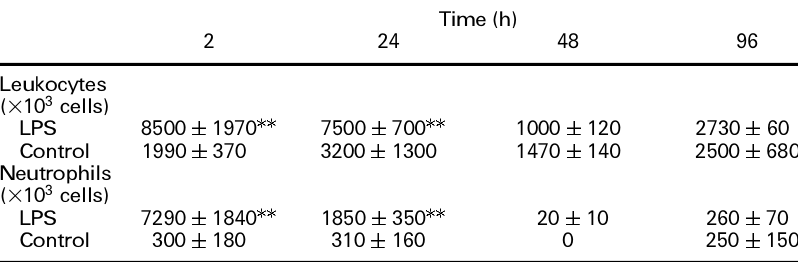
Table 1. Time-course of the LPS-induced leukocyte and neutrophil recruitment into rat air pouches. Leukocyte and neutrophil recruitment was evaluated at different time-points (2 h, 24 h, 48 h and 96 h) for the dose of 200 ng of LPS injected into the air pouches under a volume of 1 ml. Results are expressed as mean SEM for n = 5 ± 7 experiments ( P , 0.01)